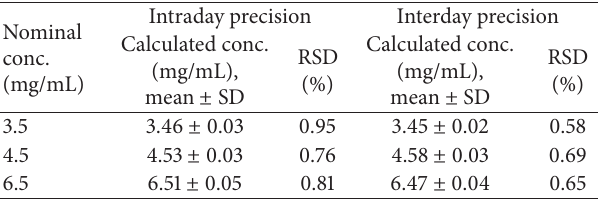
Table 2: Precision study of the method.